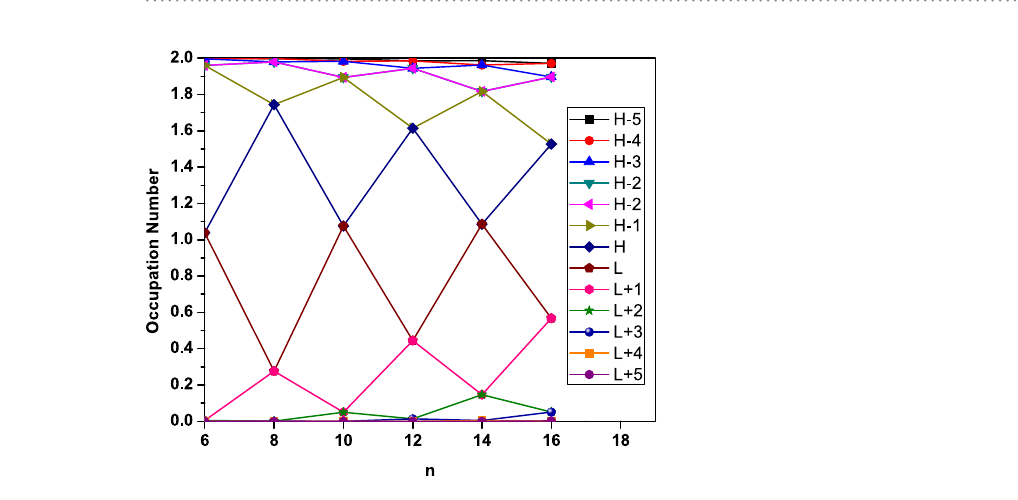
Figure 5. Symmetrized von Neumann entropy for the ground state of Li 2 B n , obtained with TAO-BLYP-D.